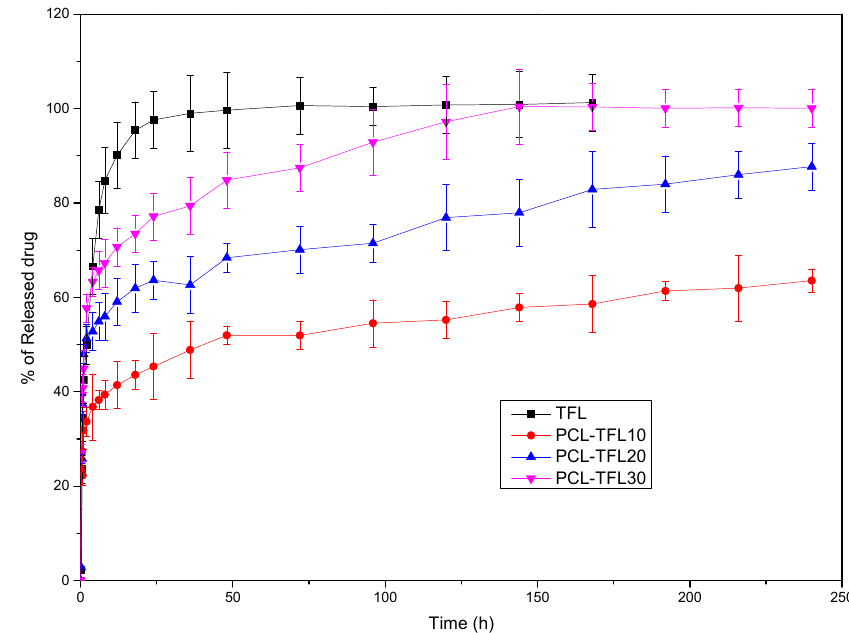
Figure 9. In vitro dissolution profiles of the prepared TFL loaded nanofibrous patches.